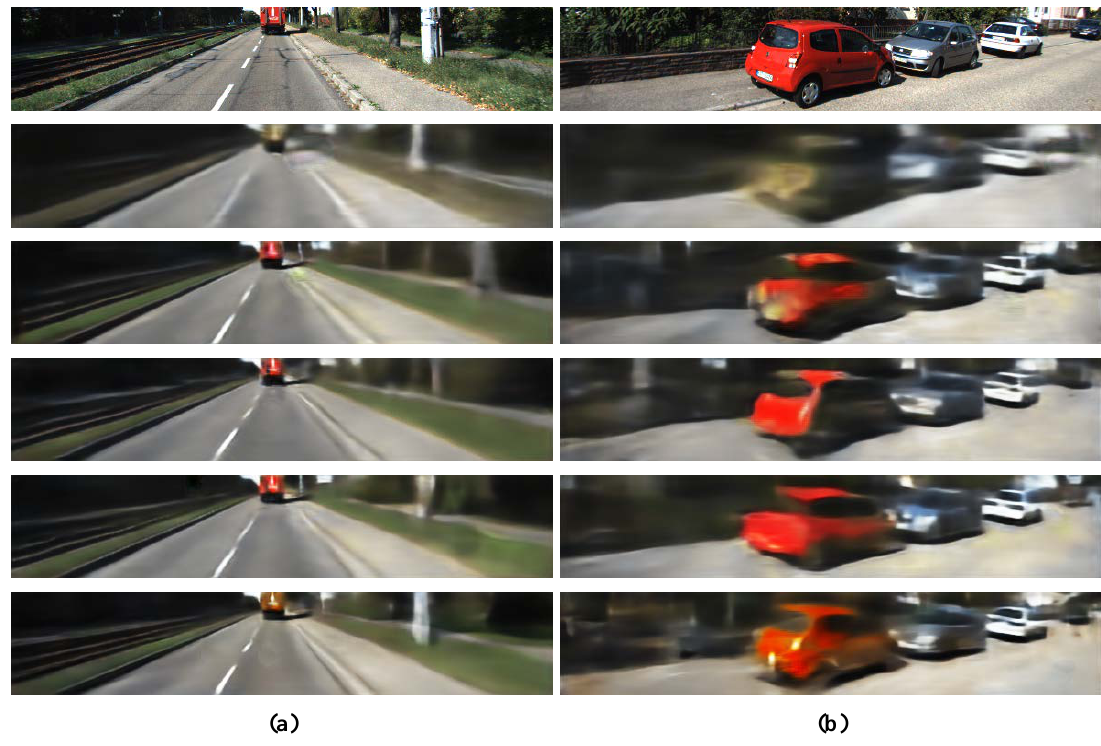
Figure 4. Two representative inference examples. ( a ) shows that the white road-pillar located on the right side does not appear in the reflection-based single-input network. ( b ) shows that the visual qualities are similar to the objective performances shown in Tables 1 and 3. The GT color image is shown in the top row. The second to sixth rows are the images generated by range-based (in the second row) and reflection-based (in the third row) single-input networks and early fusion (in the fourth row), mid fusion (in the fifth row), and last fusion-based multi-input networks (in the sixth row),